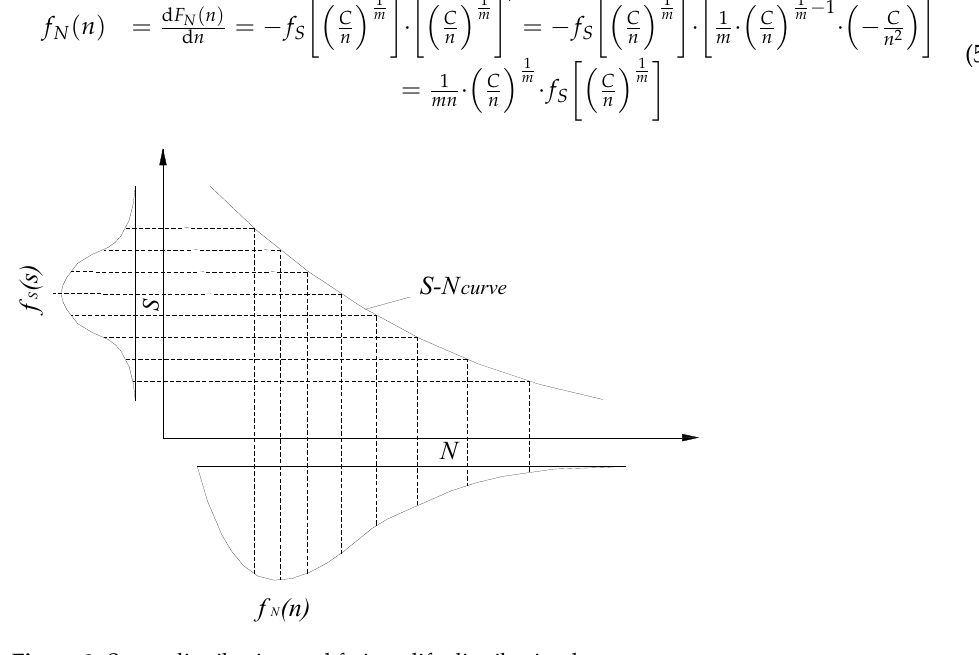
Figure 2. Stress distribution and fatigue life distribution law .